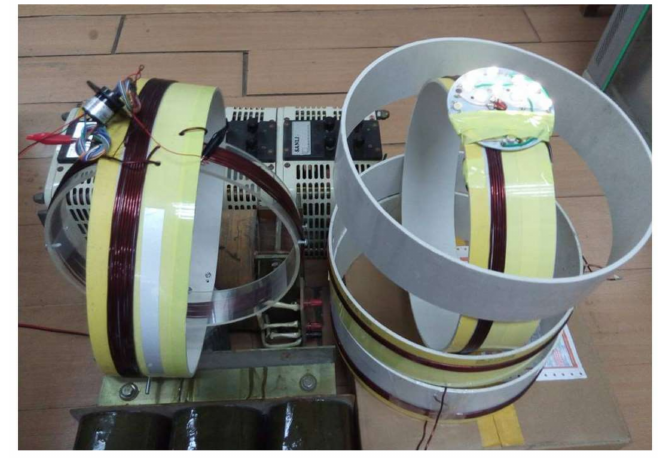
Figure 14. Experiment setup of two rotary transmitting